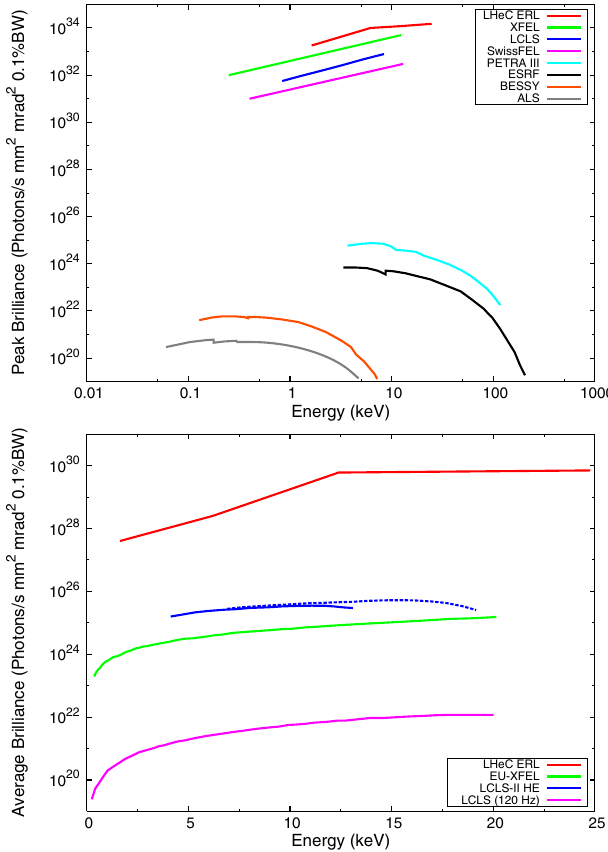
FIG. 7. Comparison of FEL peak and average brilliance for the LHeC-FEL with several existing or planned hard x-ray FEL and SR